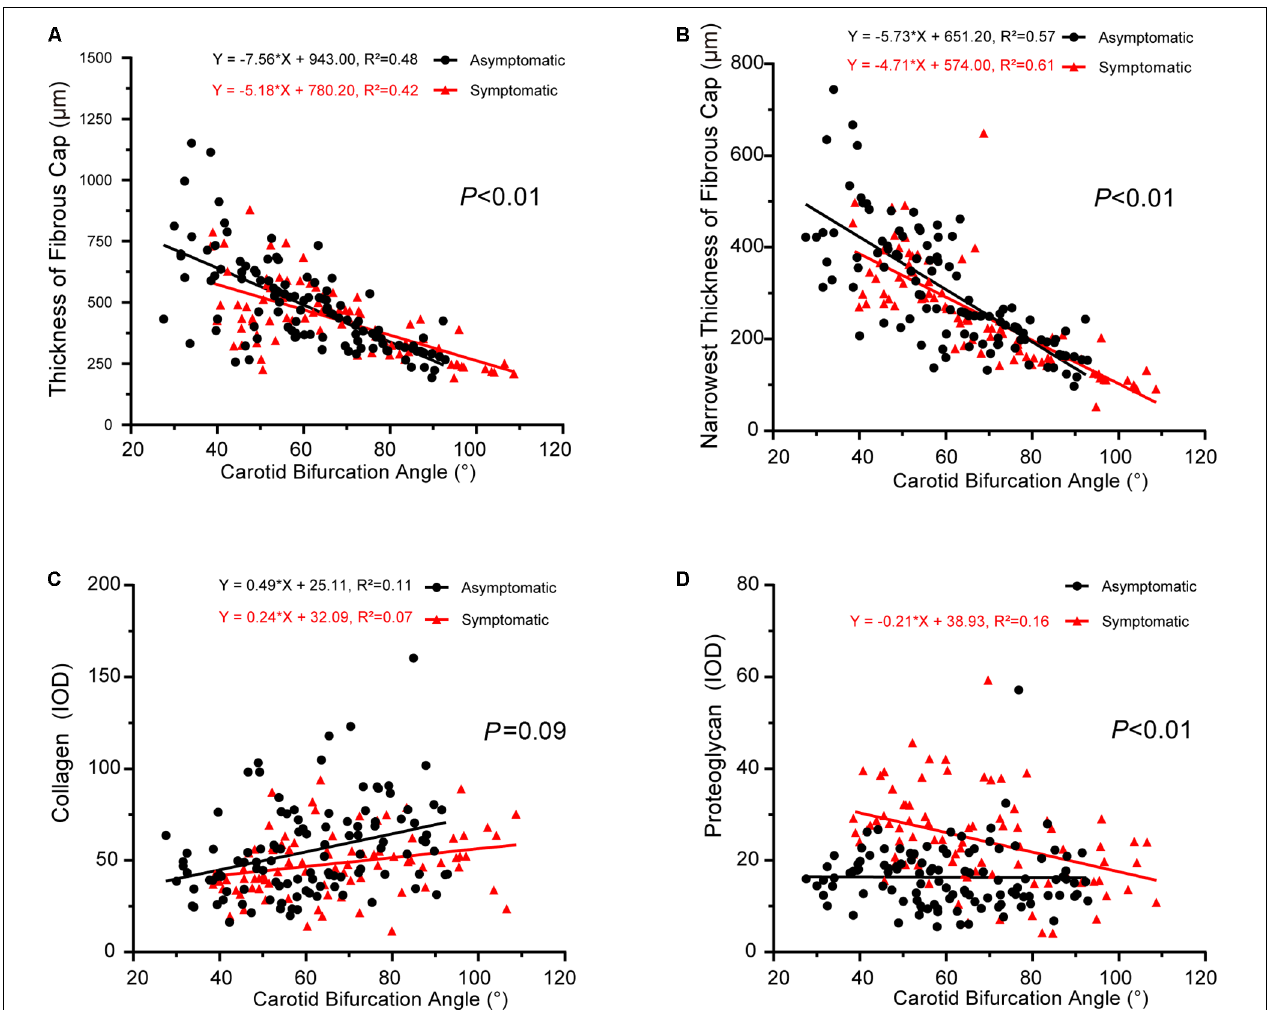
FIGURE 4 | Correlation between carotid bifurcation angle and plaque pathology. (A) Linear regression model of fibrous cap thickness and carotid bifurcation angle (asymptomatic: P < 0.001, R 2 = 0.48; symptomatic: P < 0.001, R 2 = 0.42); interaction between two groups had statistical significance ( P < 0.01). (B) Linear regression model of narrowest thickness of fibrous cap and carotid bifurcation angle (asymptomatic: P < 0.001, R 2 = 0.57; symptomatic: P < 0.001, R 2 = 0.61); interaction between two groups had statistical significance ( P < 0.01). (C) Linear regression model of collagen and carotid bifurcation angle (asymptomatic: P < 0.001, R 2 = 0.11; symptomatic: P < 0.001, R 2 = 0.07); interaction between two groups had no statistical significance ( P = 0.09). (D) Linear regression model of proteoglycan and carotid bifurcation angle (asymptomatic: P > 0.05; symptomatic P < 0.001, R 2 = 0.16); interaction between two groups had statistical significance ( P <